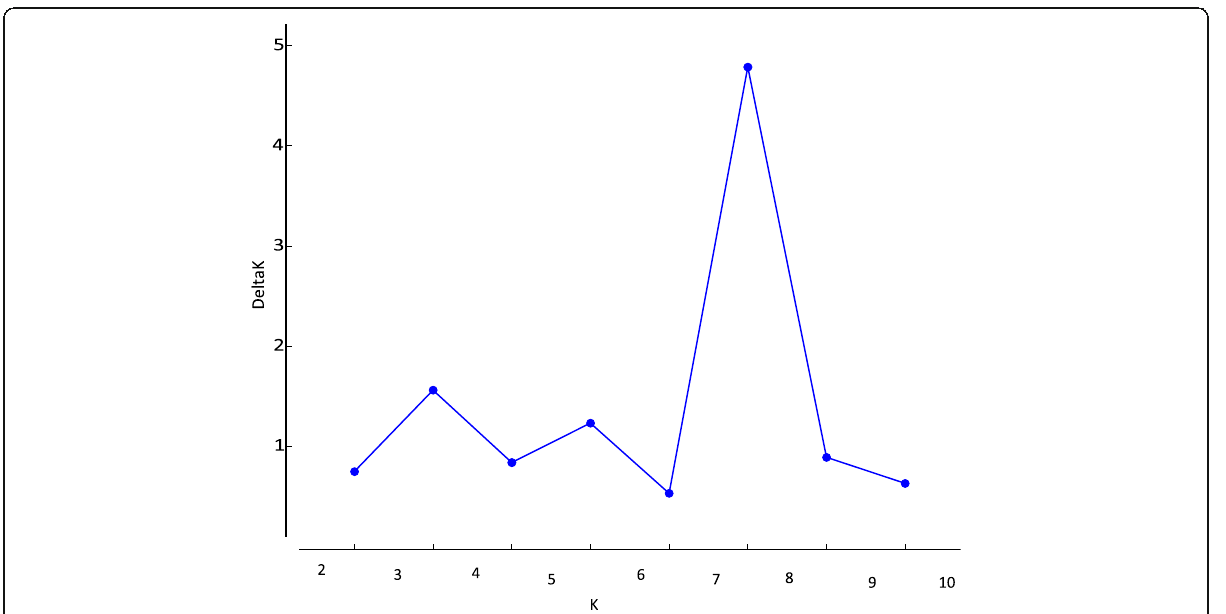
Fig. 5 Population structure of seven mung bean genotypes based on SSR